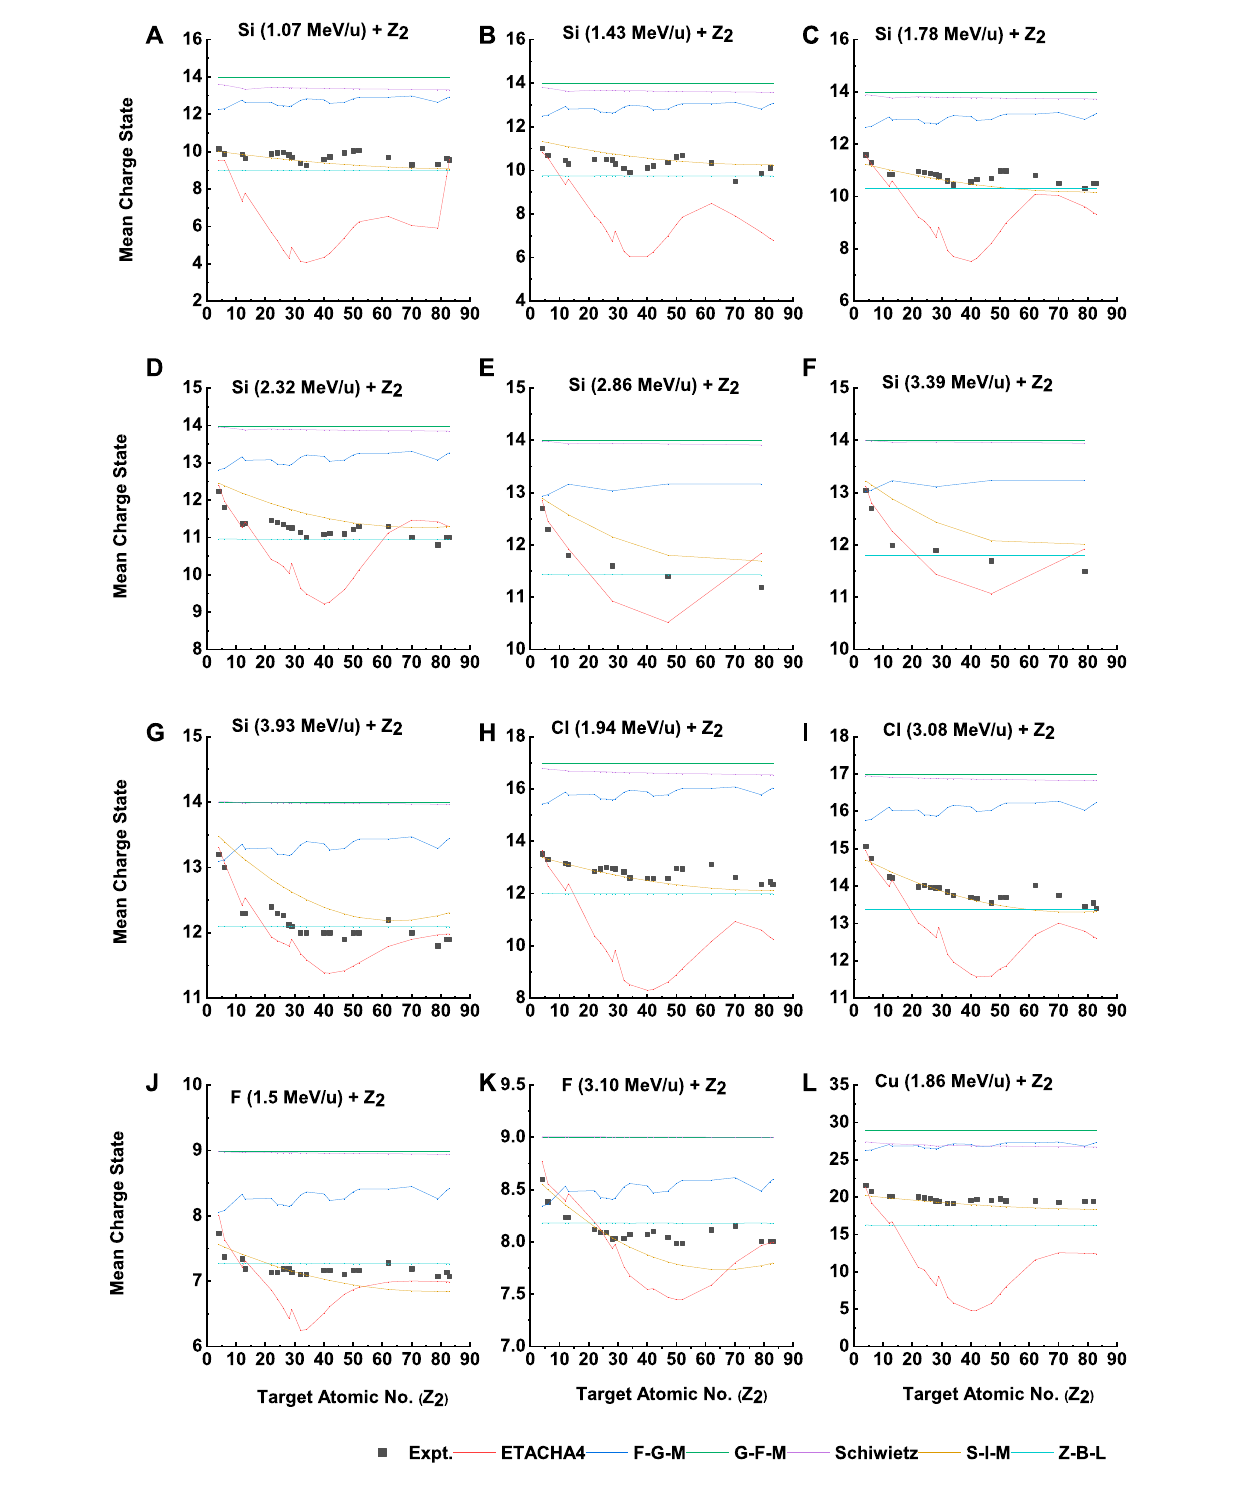
FIGURE 1 The equilibrium mean charge state vs. target atomic number for Si (A – G) , Cl (H, I) , F (J, K) , and Cu (L) projectiles at different energies. Experimental data are taken from Ref. 26. The solid lines are provided only to guide the eye.